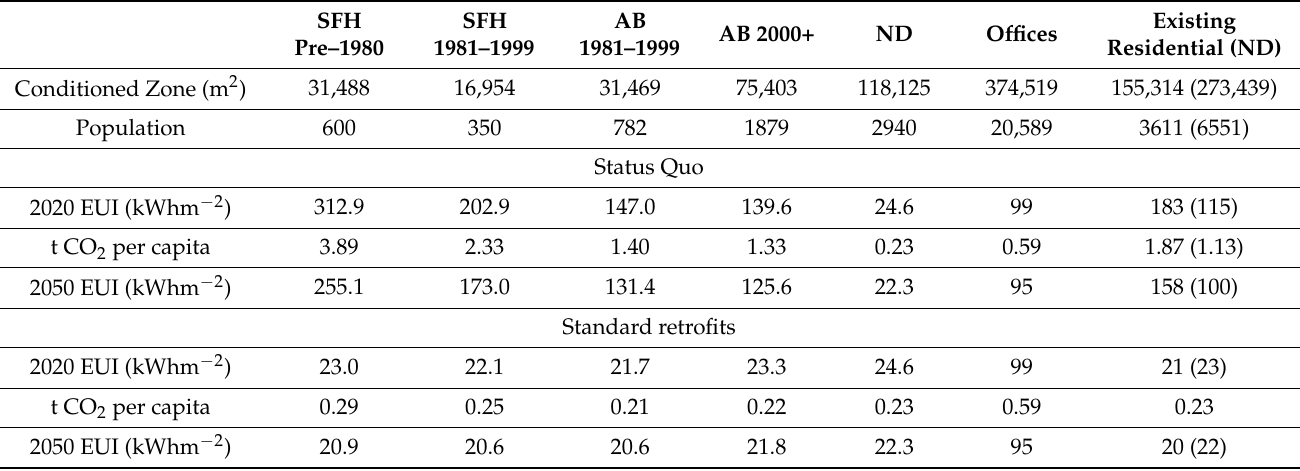
Table 2. Summary of UMI simulation results for the residential sector in the study area. The CO 2 emissions are estimated using 0.237 kg CO 2 (kWh) − 1 based on the fuel mix in